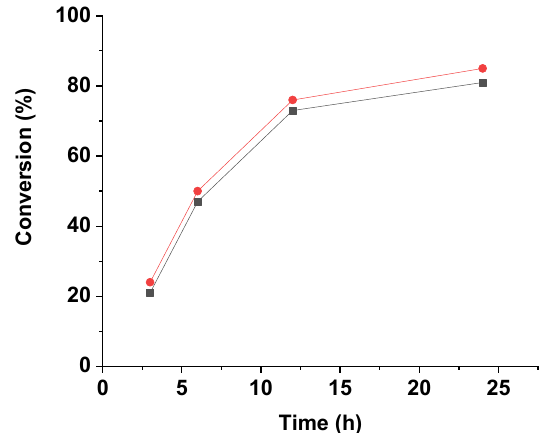
Figure 3. Time dependence of conversion using LaCoODA as catalyst. Non-activated ( ■ ); activated ( ● ).